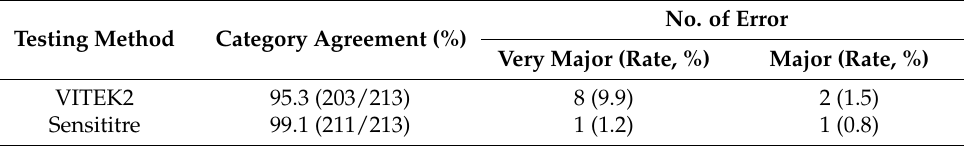
Table 1. Agreements of colistin susceptibility results between different antimicrobial susceptibility testing methods and broth microdilution.